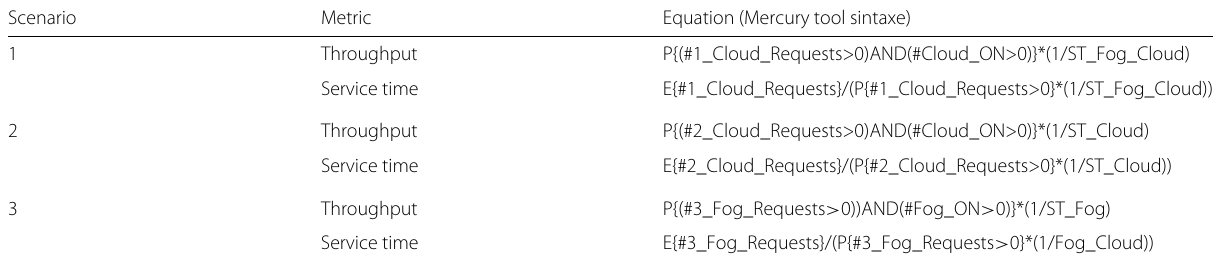
Table 3 Equations for performance metrics